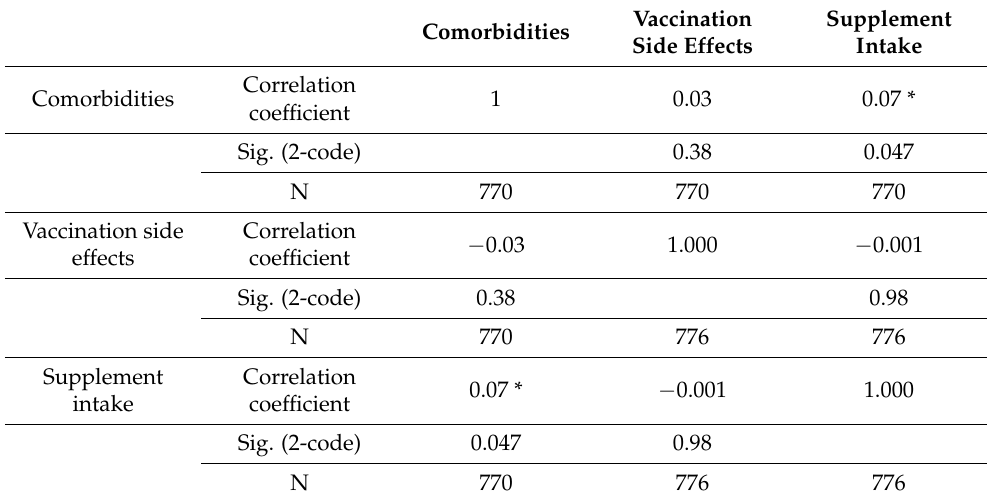
Table 4. Correlation between vaccination side effects, supplement intake, and comorbidities at the start of the vaccination